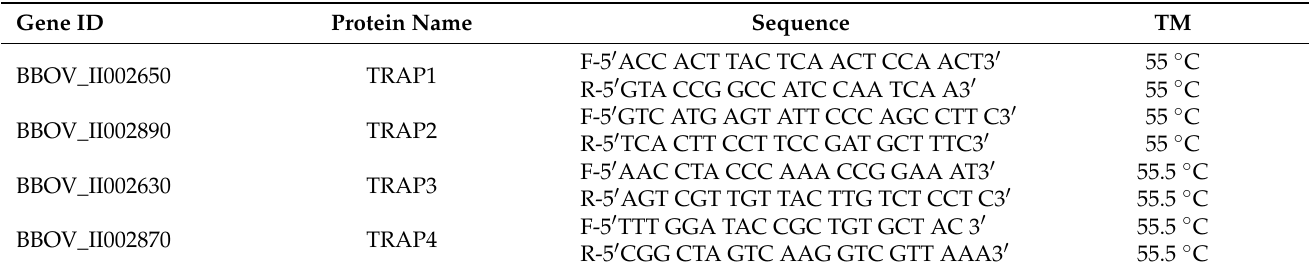
Table 1. Quantitative PCR primers used to determine the number of transcripts expressed by B. bovis blood stages, in vitro induced sexual stages, and kinetes.